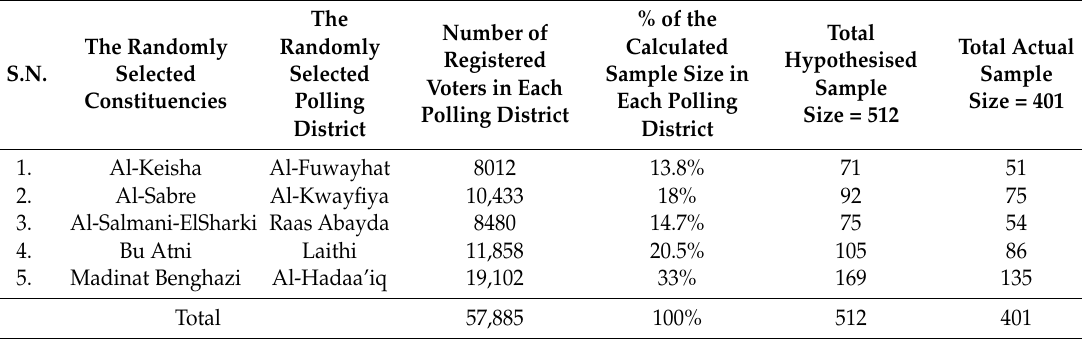
Table 1. Sampling